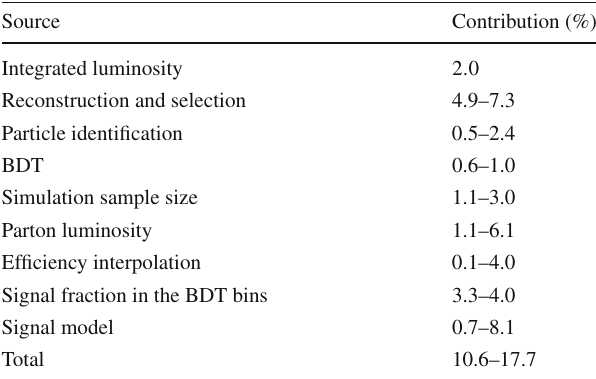
Table1 Contributionstotherelativesystematicuncertaintiesin%.The contributions are grouped in three categories, the integrated luminosity, the detection efficiency and the signal yield, separated by horizontal lines.Thedetectionefficiencyisaffectedbythepartonluminositymodel and depends upon the production process, with a maximum uncertainty